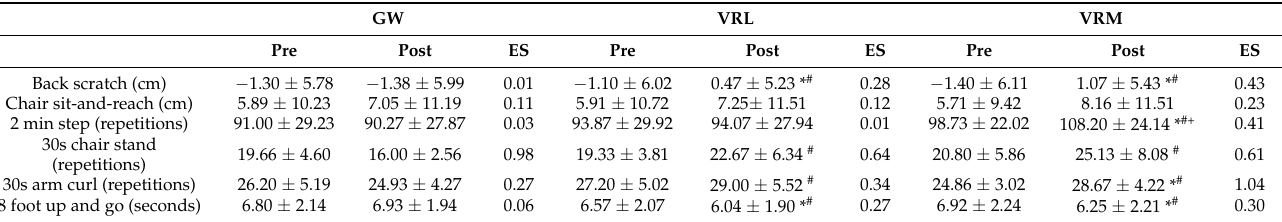
Table 2. Mean ± Standard Deviation of shoulder (back scratch), lower-body flexibility (chair sit-and-reach), aerobic endurance (2 min step), lower-body strength (30 s chair stand), upper-body strength (30 s arm curl), agility and dynamic balance (8 foot up and go) before and after three warm-up protocols. GW VRL VRM